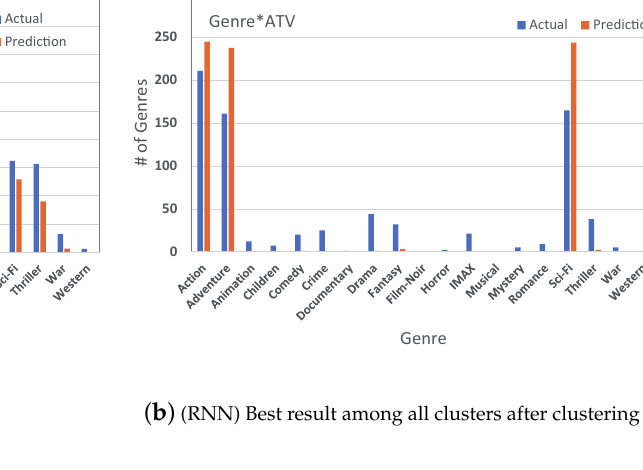
( a ) (RNN) Result without clustering ( b ) (RNN) Best result among all clusters after clustering